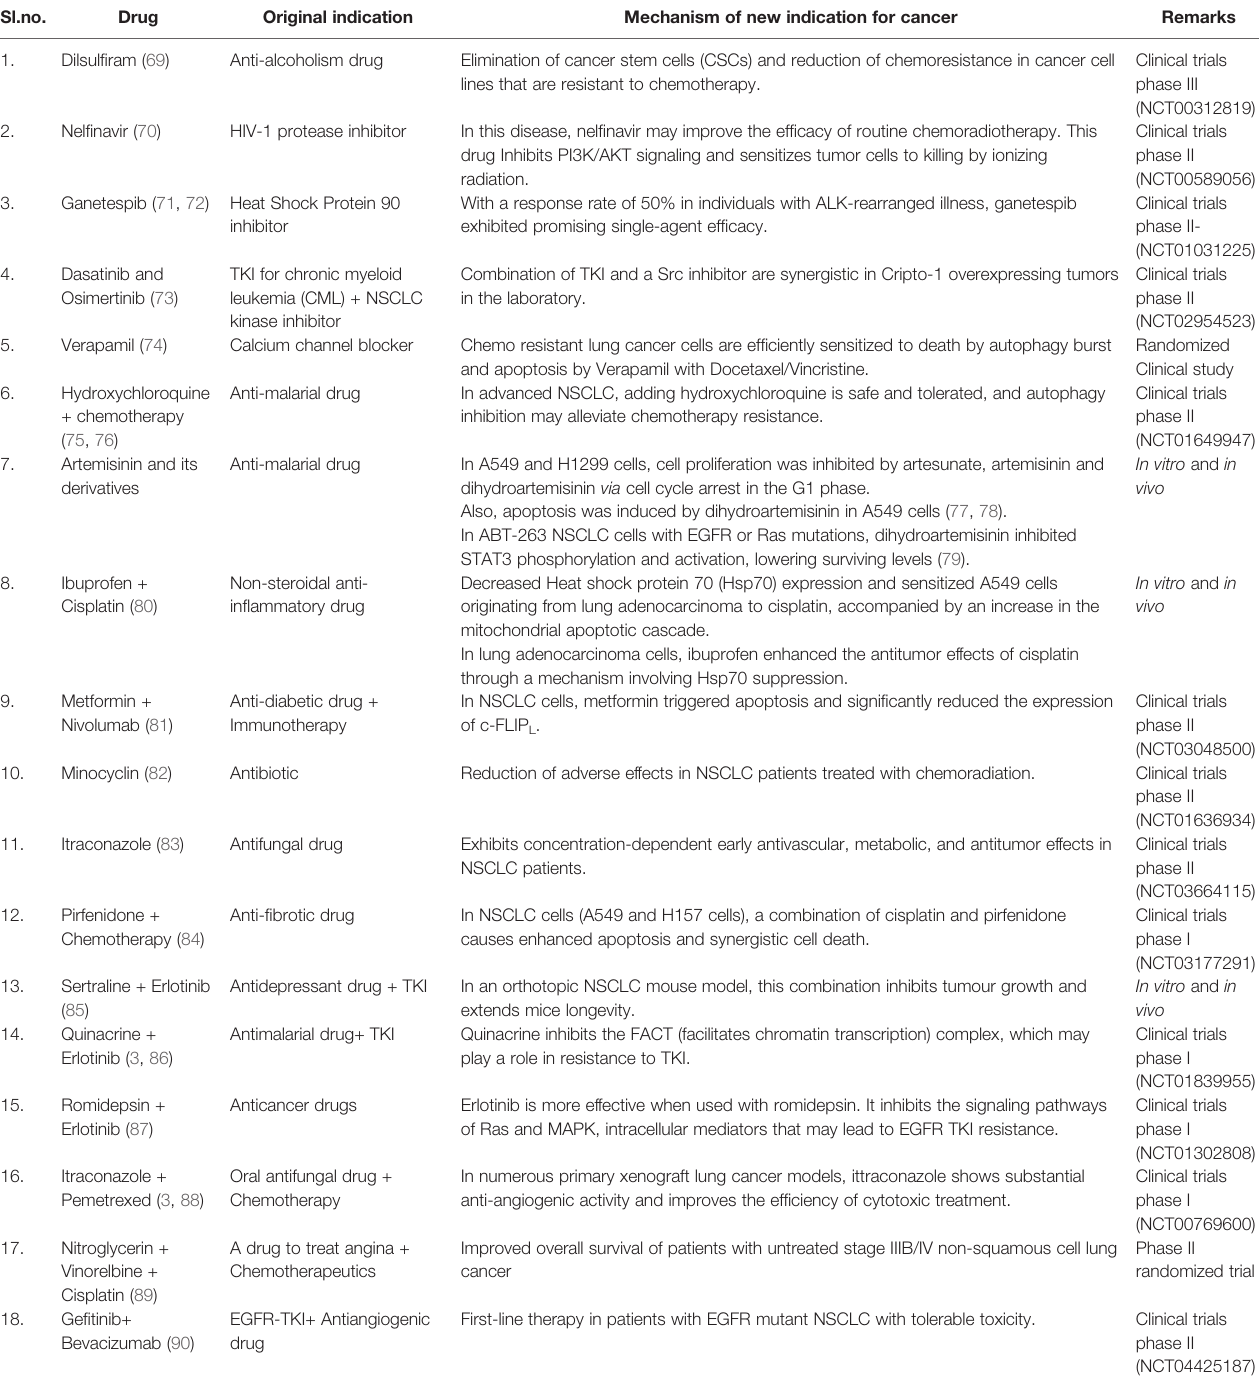
TABLE 2 | Details of drugs reported to be repurposed for NSCLC therapy.